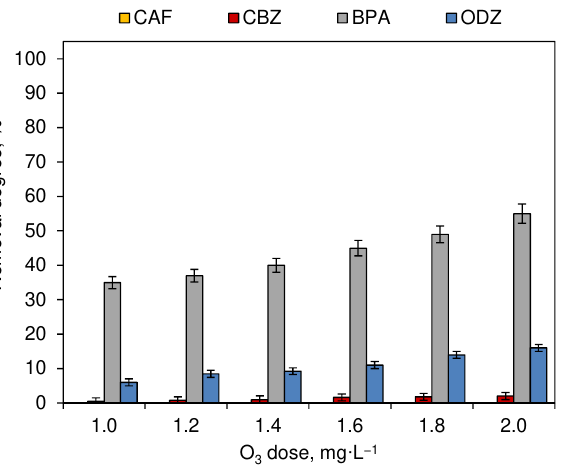
Figure 3. Influence of O 3 dose on the removal degree of CECs (dark chamber experiment; n = 3; where CAF—caffeine, CBZ—carbamazepine, BPA—bisphenol A, ODZ—oxadiazon).